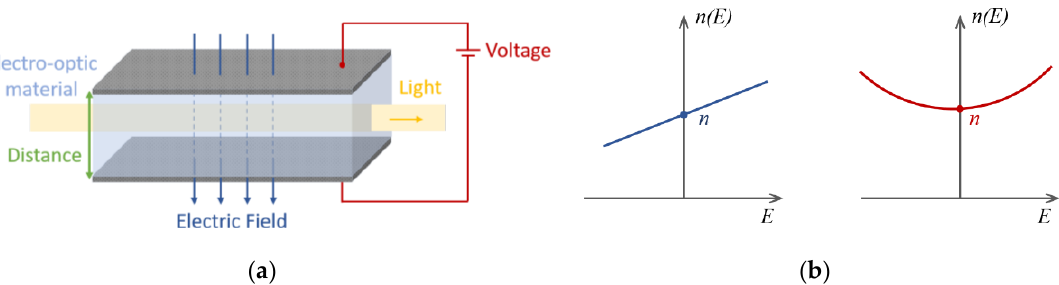
Figure 1. ( a ) The application of a steady electric field to an electro-optic material results in the change of its refractive index, modifying the effect of the material over traveling light.; ( b ) Representation of the LEO and QEO, respectively, in an electro-optic material.